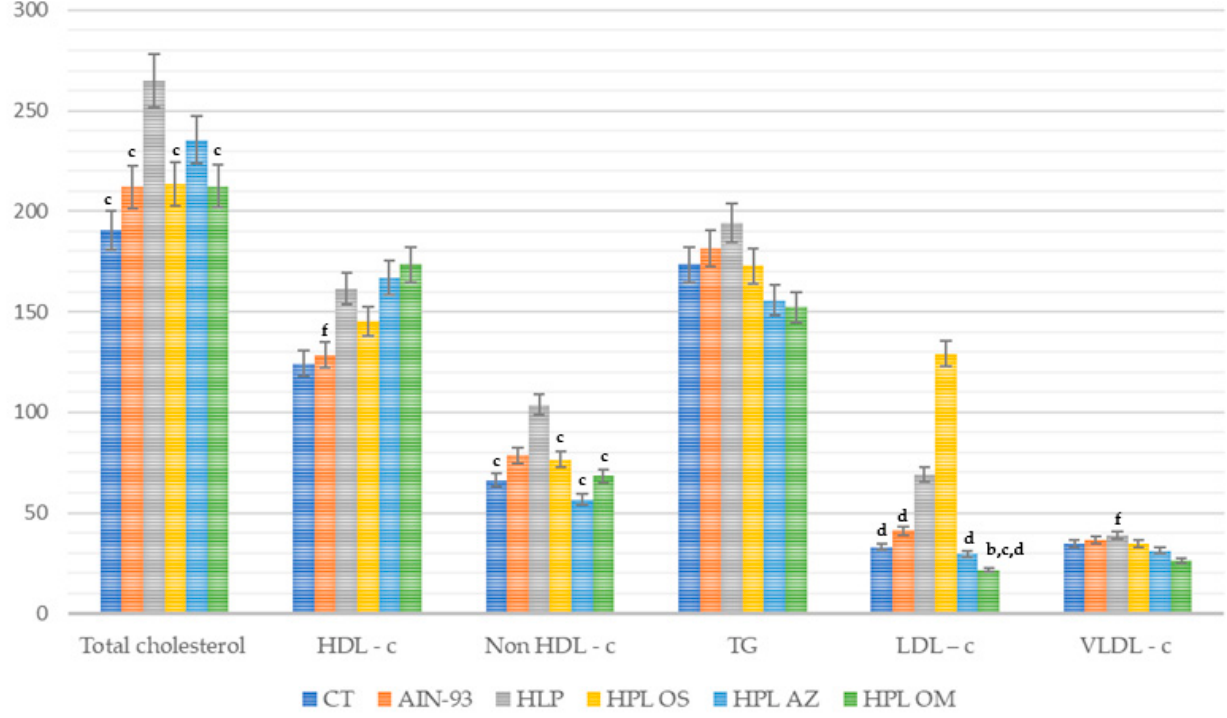
Total cholesterol values were lower in the HPL OM, with a statistical difference when compared to the HPL group ( p = 0.002) (Figure 4).